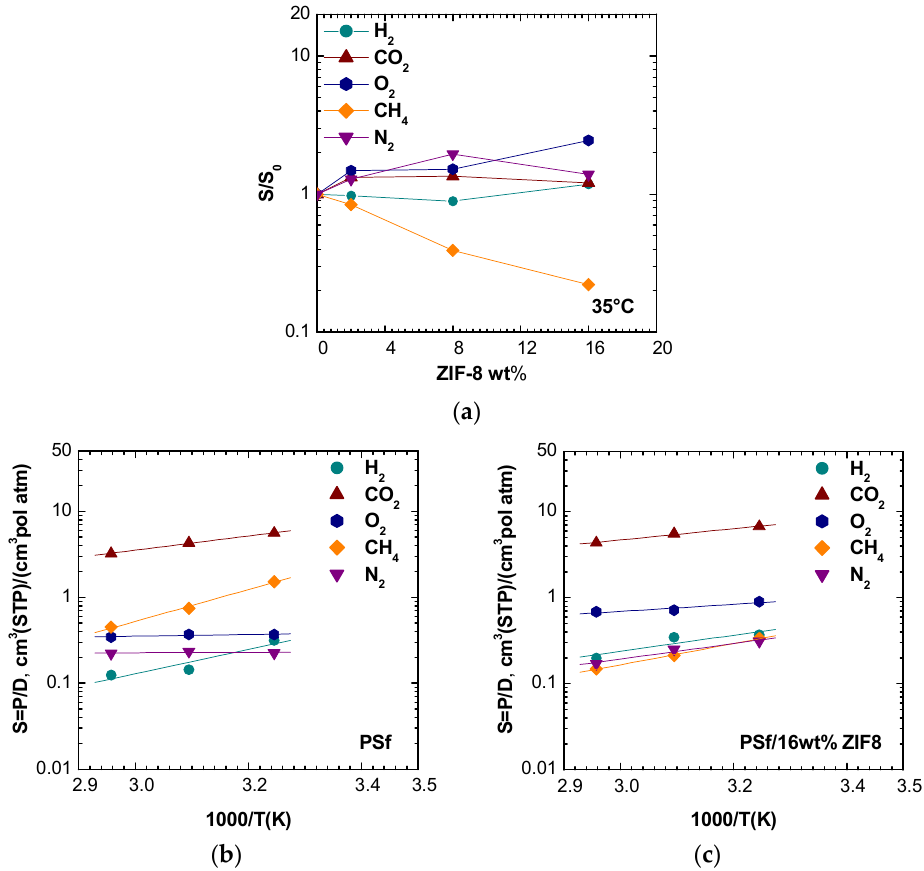
Figure 14. ( a ) Solubility enhancement observed after adding ZIF-8 to PSf for various gases at 35 °C. Solubility versus 1000/T for ( b ) PSf; ( c ) PSf/16% ZIF-8.